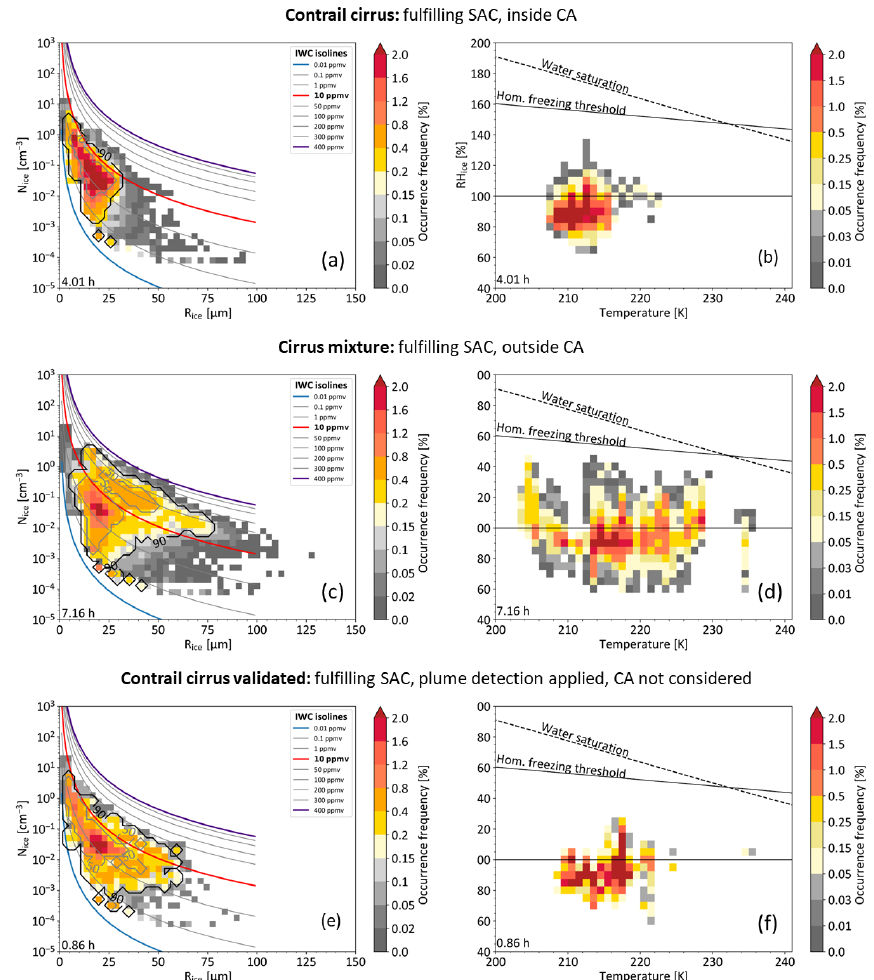
Figure 5. N ice – R ice (a, c, e) and RH ice – T amb (b, d, f) relations colour-coded by normalized occurrence frequency, similar to Fig. 4a and d. (a, b) The contrail cirrus fulfilling the Schmidt–Appleman criterion (SAC) and found inside the cruising altitude range (CA; ambient pressure 200–245hPa) (median: N ice = 0 . 045cm − 3 and R ice = 16 . 6µm). (c, d) The cirrus mixture fulfilling SAC and outside the CA range (in situ- and liquid-origin cirrus) (median: N ice = 0 . 038cm − 3 and R ice = 24 . 1µm). (e, f) Contrail cirrus with plume detection applied and fulfilling the SAC (median: N ice = 0 . 027cm − 3 and R ice = 21 . 7µm), but the CA range is not considered